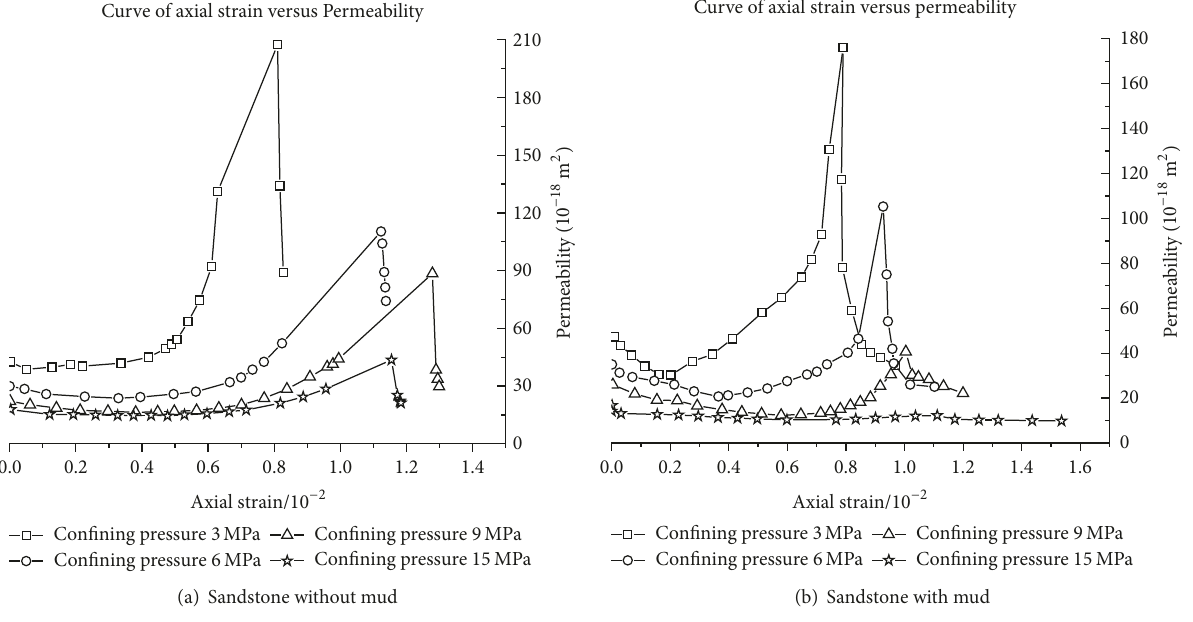
Figure 6: Permeability evolution of two reservoir sandstones considering water pressure 2MPa and different confining pressure.